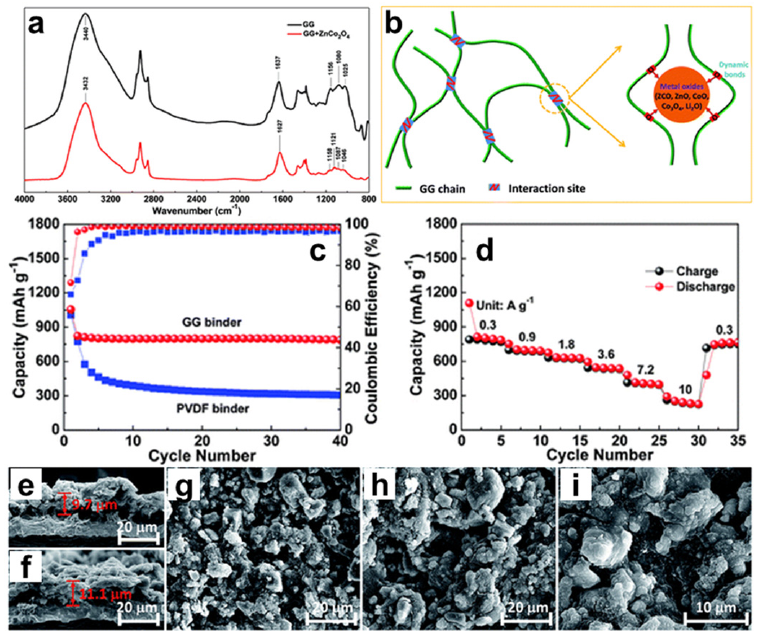
Figure 3. ( a ) FTIR spectra of GG and ZnCo 2 O 4 mixed with GG. ( b ) Schematic illustration of the mechanically stable network formed between GG and metal oxides (ZnCo 2 O 4 ). ( c ) Comparison of cycle retention characteristics of ZnCo 2 O 4 used with GG and PVdF binder. ( d ) Rate capabilities tests of ZnCo 2 O 4 used with GG binder. Cross-section SEM images of ZnCo 2 O 4 with GG binder ( e ) before cycling and ( f ) after the first cycle. SEM images of ZnCo 2 O 4 with GG binder ( g ) before cycling, ( h , i ) after the first cycle [54].